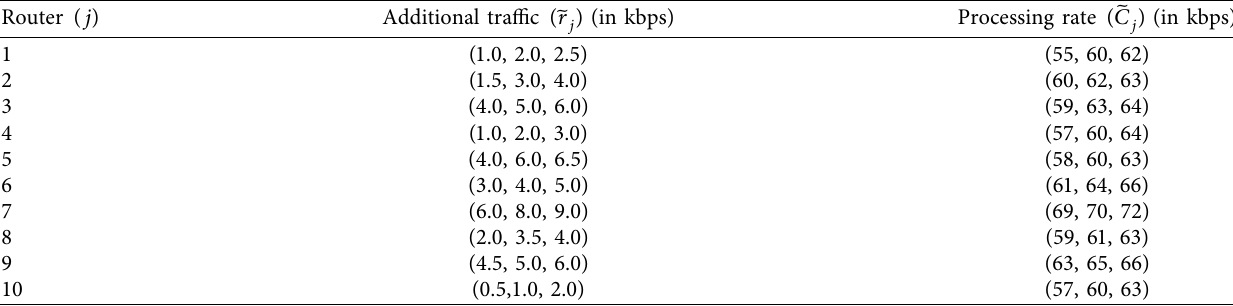
) of each server. j